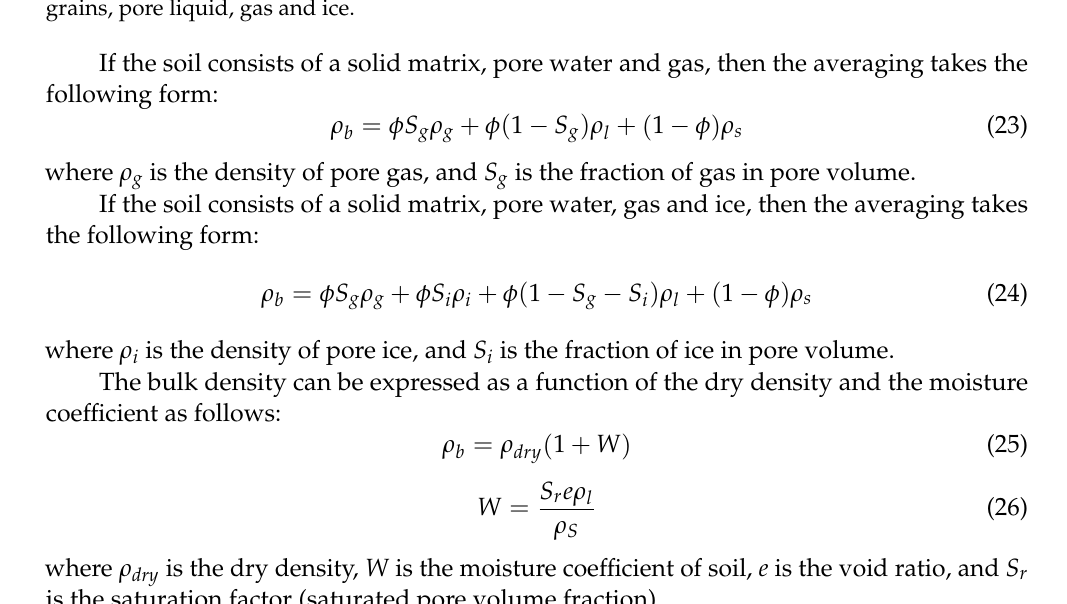
Figure 2. Schematic representation of the elementary volume of cohesive and non-cohesive soil with different moisture values and different soil structure: ( a – c )—if soil consists of soil grains and pore liquid (water); ( d – f )—if soil consists of soil grains, pore liquid and gas; ( g – i )—if soil consists of soil grains, pore liquid, gas and ice.